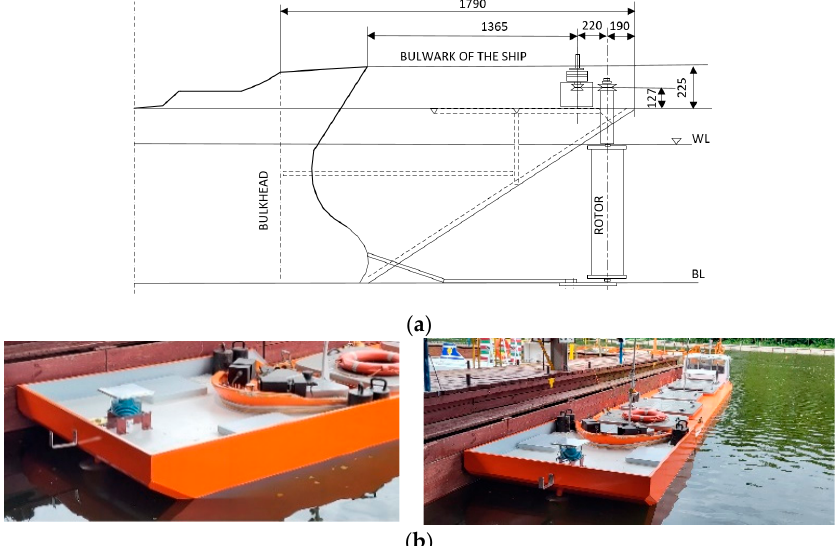
Figure 1. The new bow with RC attached to the ship model: ( a ) scheme of the construction of the new bow with rotor and drive; ( b ) ship model with the new bow.